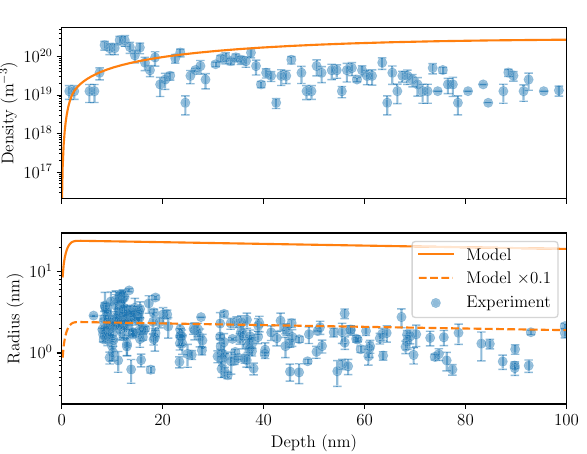
Figure 10. TEM images of W after exposure to 75 eV He at 2.3 bubbles that have burst, large size bubbles at the near surface and small size bubbles in the bulk.